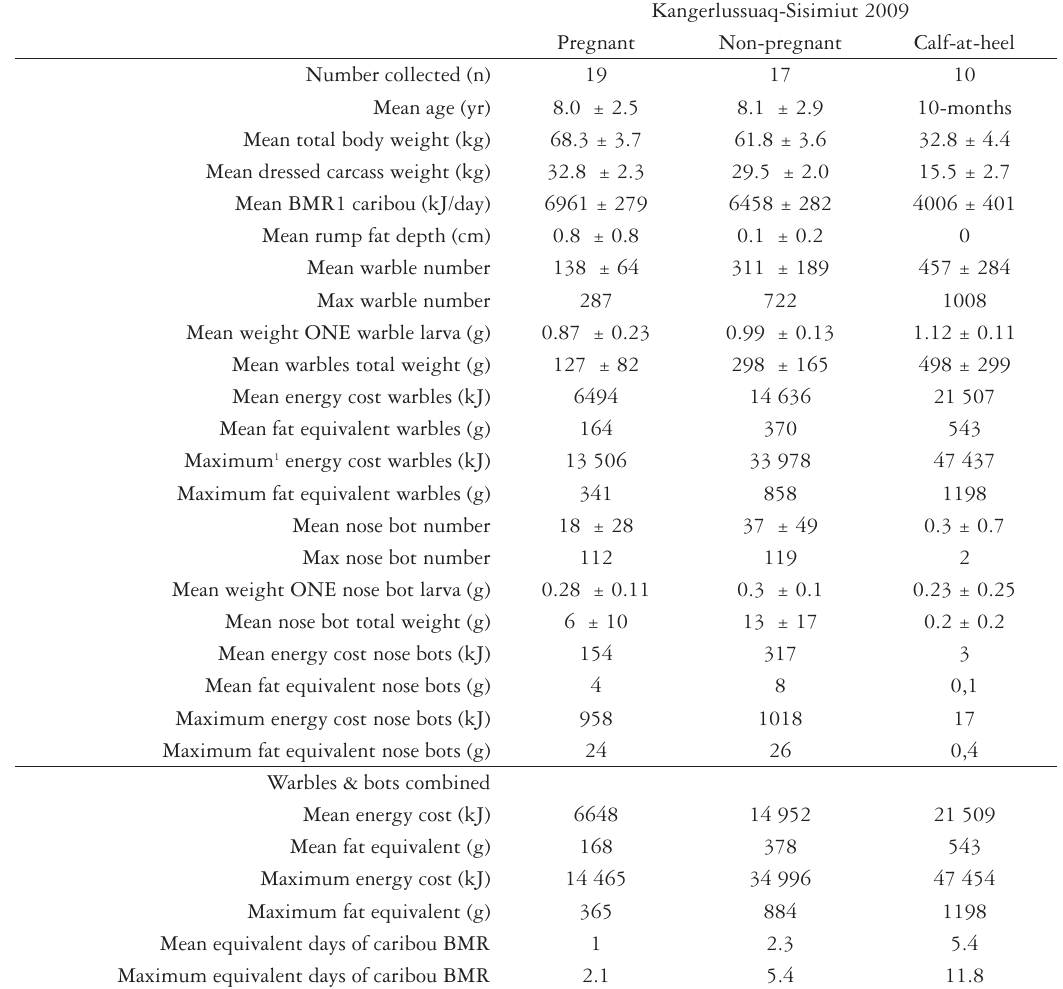
Table 2. Kangerlussuaq-Sisimiut caribou of West Greenland: data from adult cows (age > 3-years) and calves-at-heel (age 10-months) collected 3 – 17 March 2009, mean ± SD or